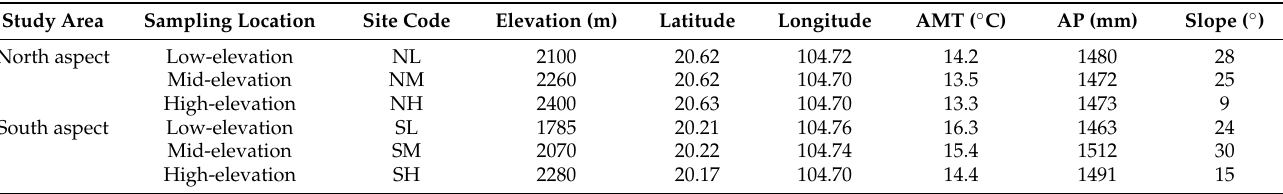
Table 1. Characteristics of sampling sites in the mountains of western Jalisco,